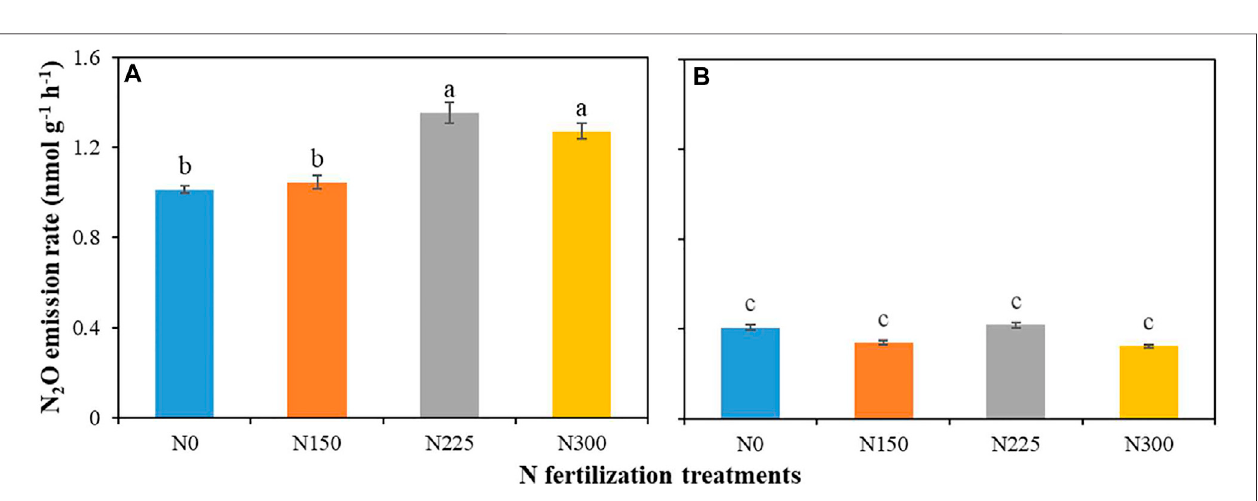
FIGURE 2 | N 2 O emission rates without DCD (A) and with DCD (B) during the incubation time. Data are the means (±1 SE). Different letters denote signi fi cant differences (ANOVA, p < 0.05) between the 4 N fertilization treatments with DCD or without DCD. The error bar means standard error. N0: 0 kg N hm − 2 a − 1 ;